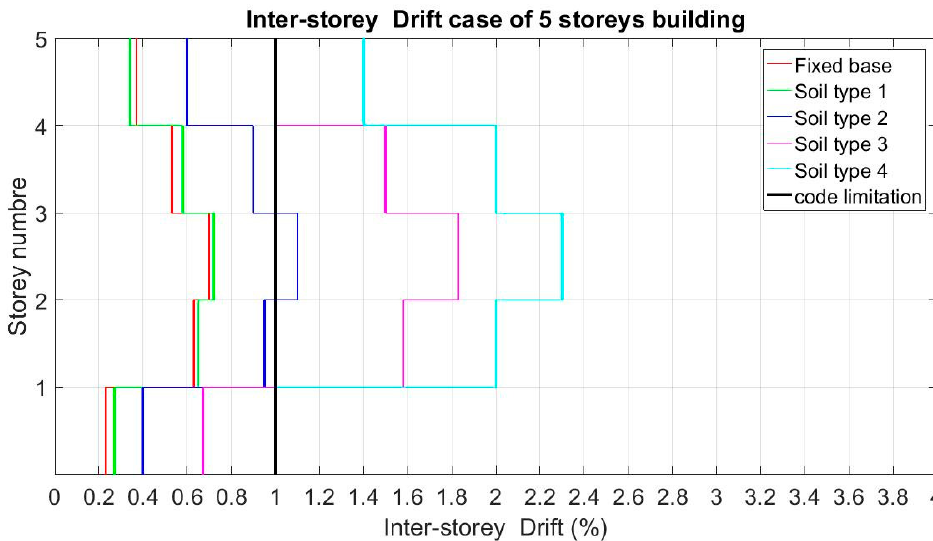
Figure 8. Inter-story drift case of a 5-story building.